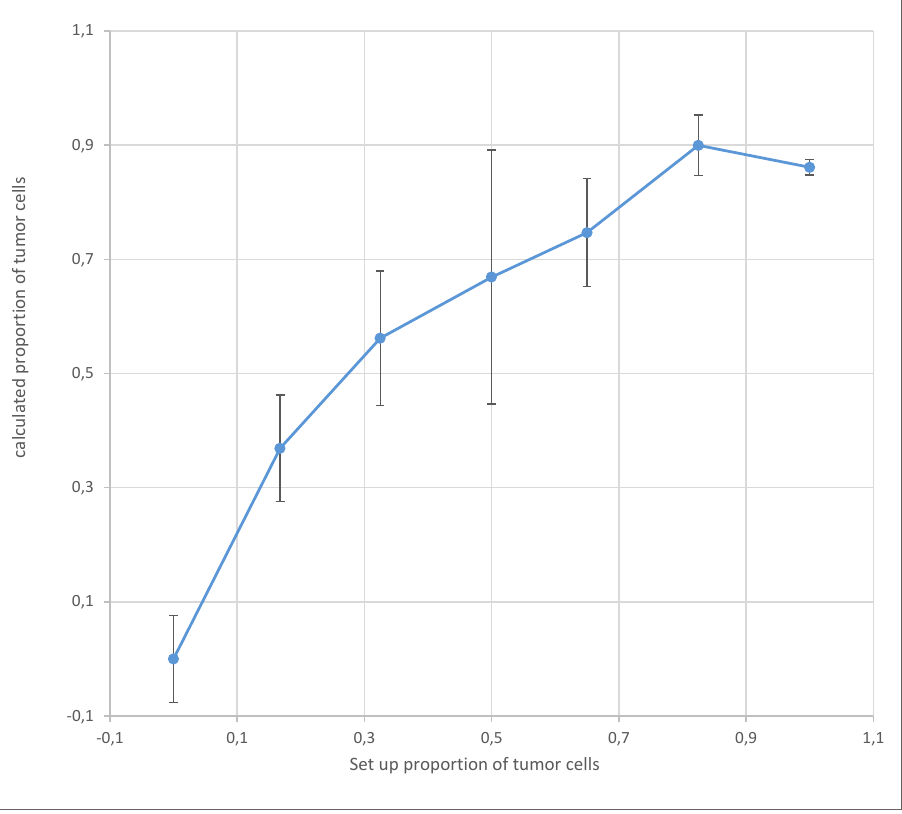
Fig. 3. Calculated proportion of tumor cells. Tumor cells and non-tumor cells were mixed at various ratios were seeded into each well of a 96-plate. After attachment overnight, the cells were treated with HotShot/Drop-dialysis and directly subjected to digital PCR which gave the ratio of NF1 : RPP30 . Base on this ratio, proportion of tumor cells in each well was calculated. Mean and standard deviation of proportion of tumor cells were calculated from 4 replicates at each set-up proportion. The calculated proportions of tumor cells (Y-axis) were plotted against the set-up proportions